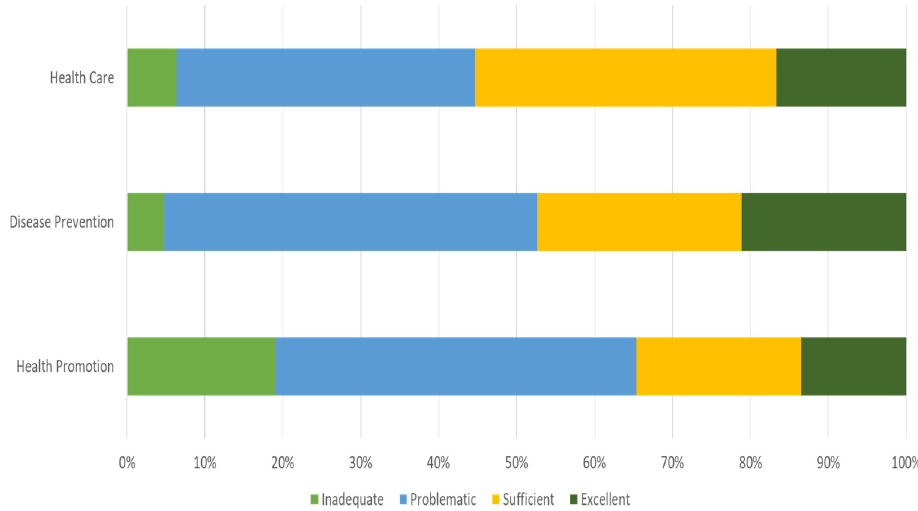
Figure 2. Caregivers’ health literacy distribution by health relevant area/categories—health literacy indexes (HLS-EU-PT).